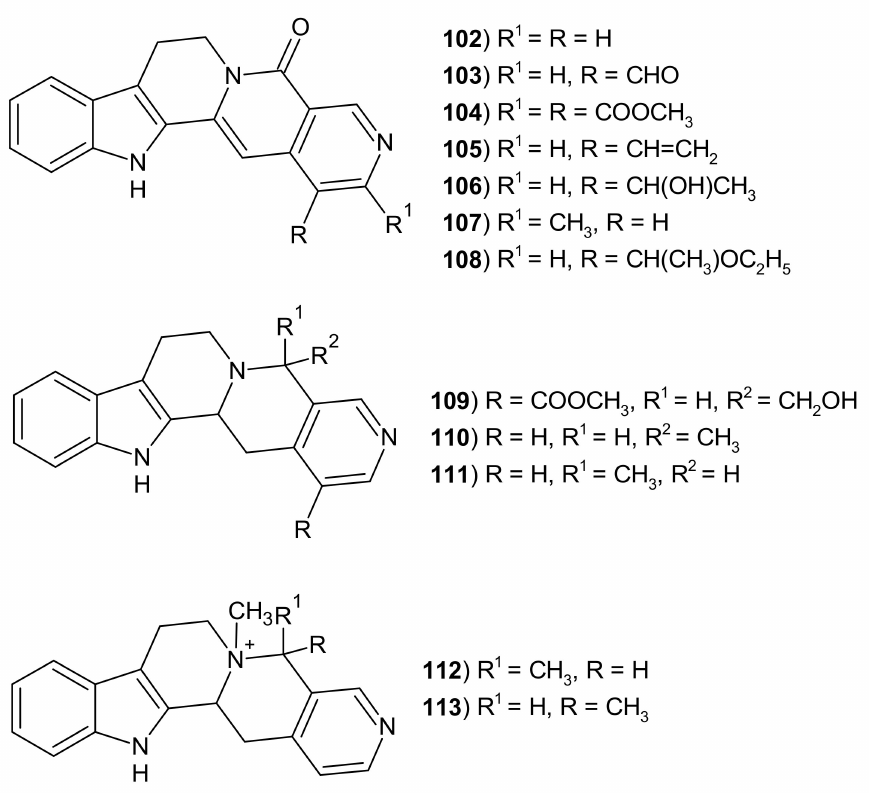
Figure 29. Structures of indolo[2 (cid:48) 3 (cid:48) :3,4]pyrido[1,2- b ][2,7]naphthyridine derivatives 102 – 113